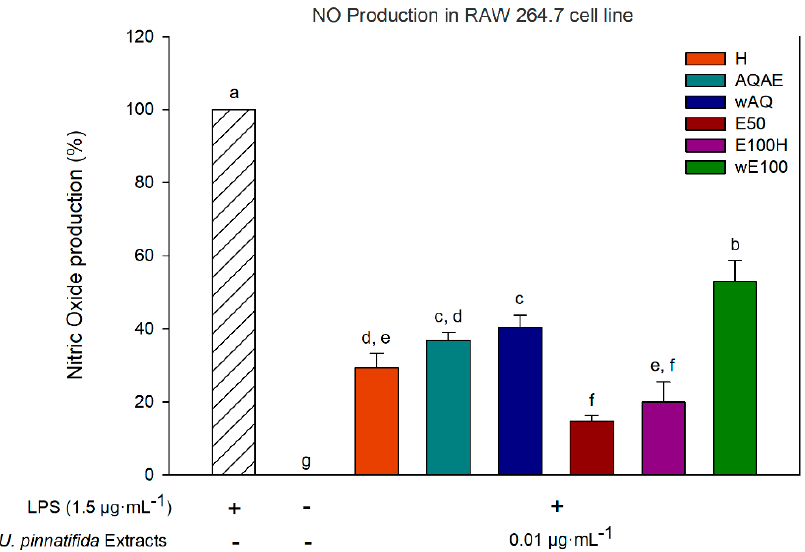
Figure 3. Nitric oxide production using the only noncytotoxic concentration (0.01 µg·mL − 1 ) that showed significant differences with the lipopolysaccharide (LPS) treated group ( p < 0.05) for each extract of Undaria pinnatifida in the evaluation of their anti-inflammatory potential, using a final concentration of 1.5 µg·mL − 1 of LPS. The results represent the mean ± SD of triplicate experiments. Bars with the same letters do not have statistically significant differences ( p > 0.05).